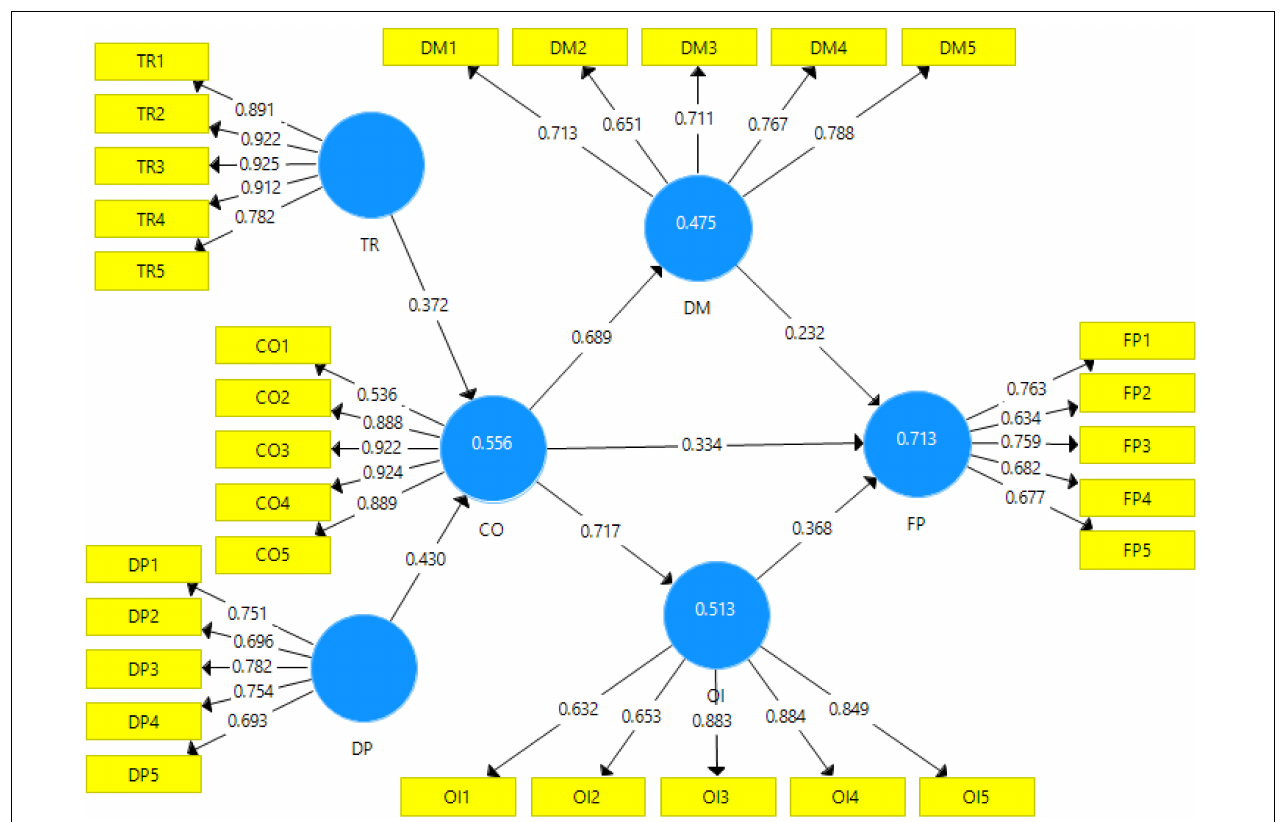
FIGURE 2 | Output of measurement model algorithm. “CO, coopetition; DP, dependency; DM, decision-making; TR, trust; OI, open innovation; and FP, firm